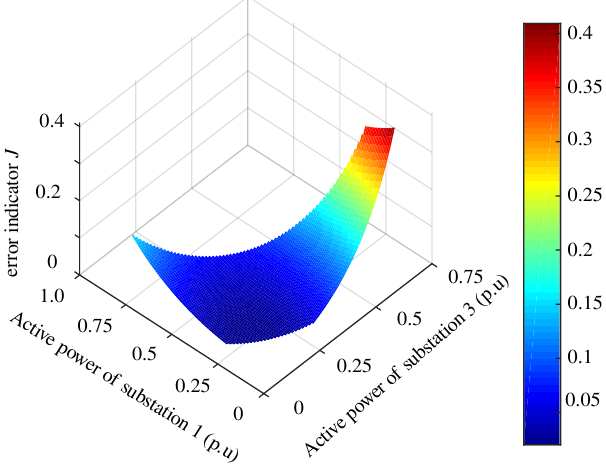
Figure 11. Error indicator J versus active power distribution among substations 1, 3, and 4.